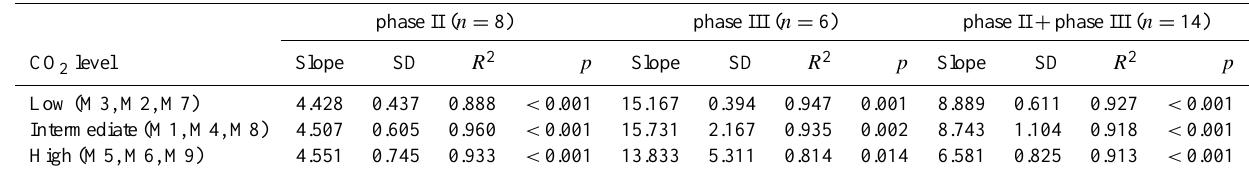
Table 3. C:N uptake ratios (Slope), standard deviations (SD) and the results of the F test on linear regression analysis in phases II and III and the post-nutrient period (phase II + phase III) (see explanations in text).